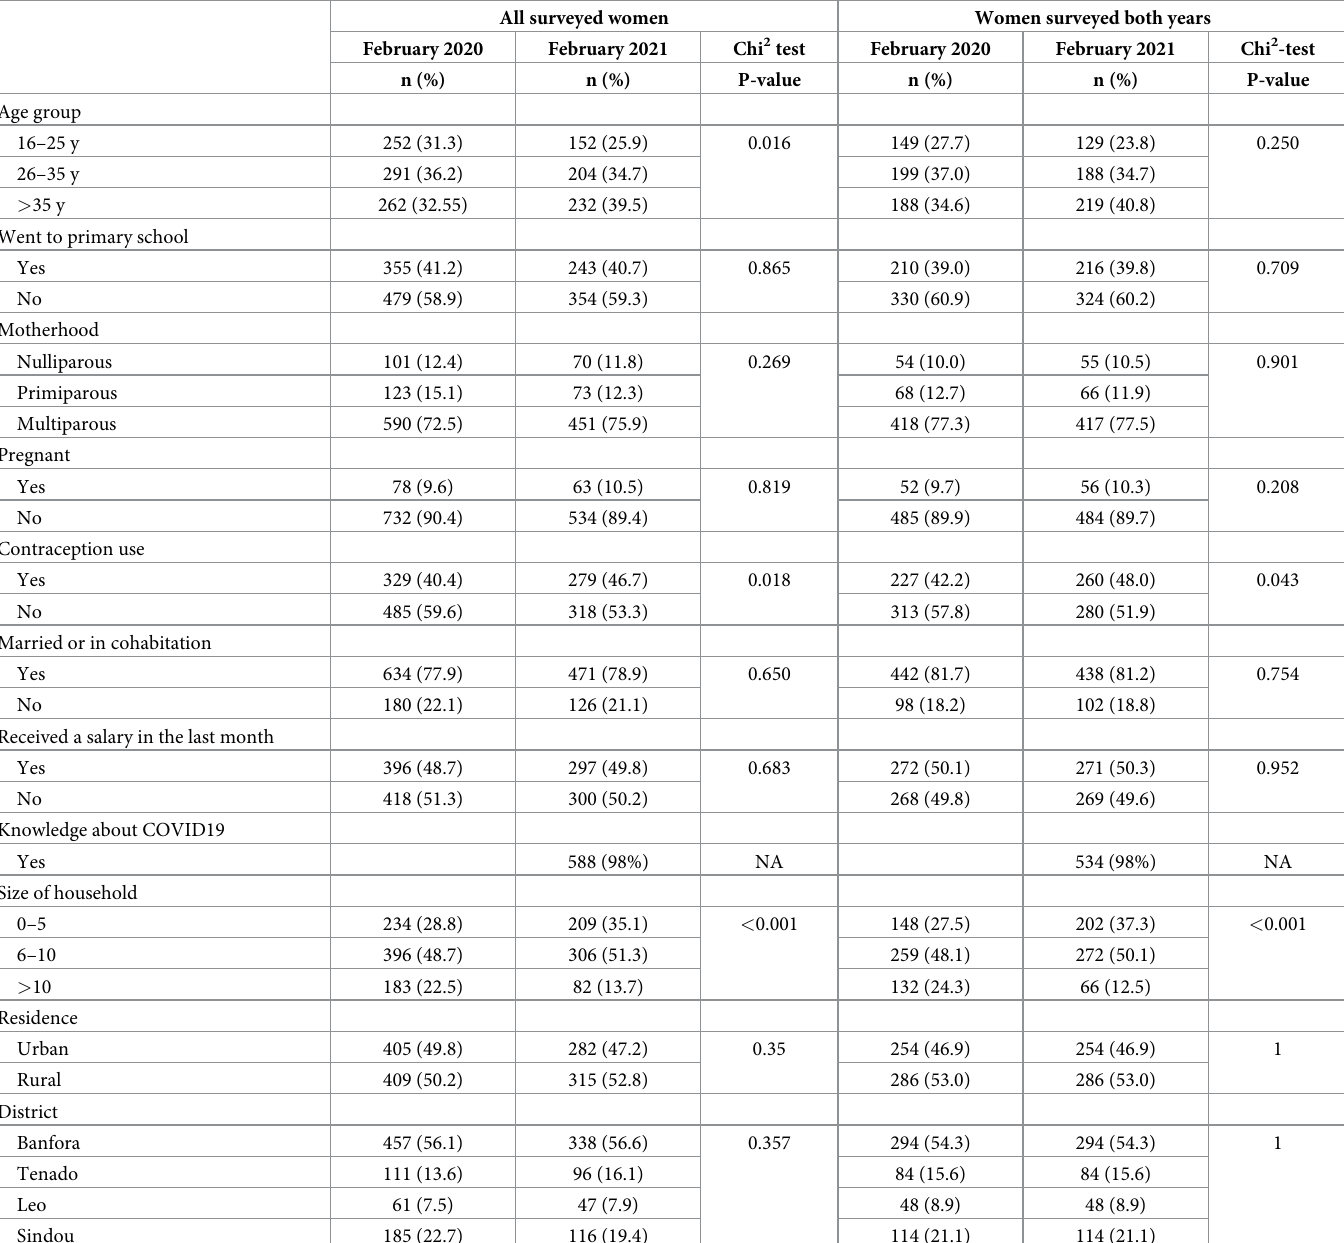
Table 1. Sociodemographic characteristics of sexually active women in the four health districts under study, in February 2020 and 2021. All surveyed